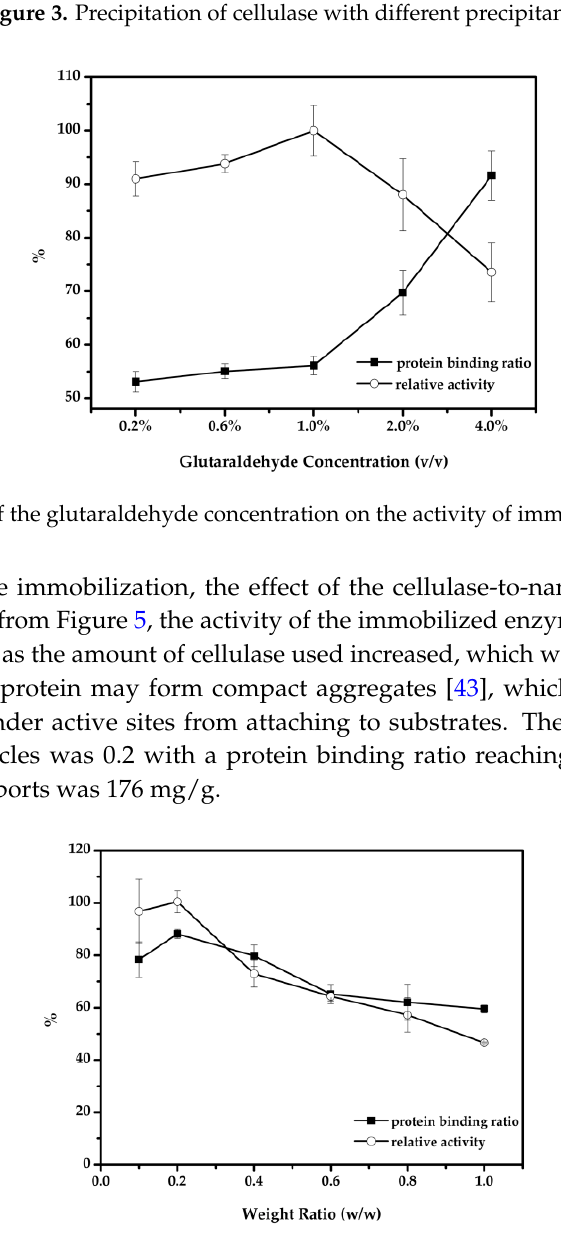
Figure 3. Precipitation of cellulase with different precipitants.